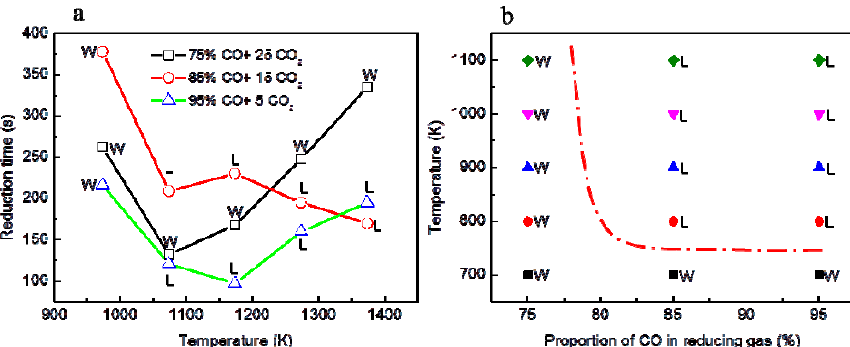
Figure 7. The relationship between reduction conditions and surface morphology of iron ore